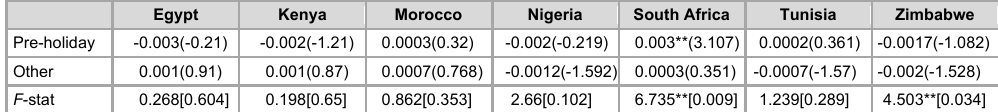
Pre-holiday effect in African stock